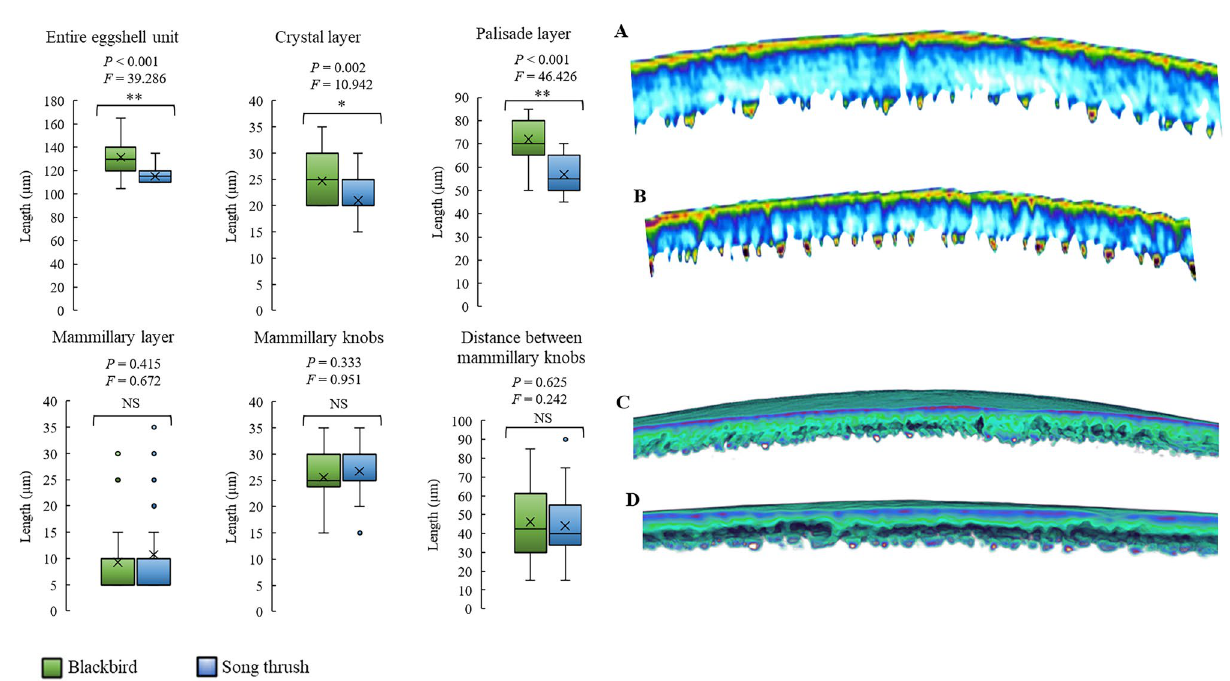
Figure 2. Comparison of the dimensions of individual layers present in the eggshell of blackbird ( Turdus merula ) and song thrush ( Turdus philomelos ). Box plots show the means (cross), standard deviation (box height), and the low and high range (vertical bars). 2D ( A and B ) and 3D ( C and D ) scans of the eggshell of blackbird and song thrush. Significant differences determined by ANOVA: ** P < 0.01; * P < 0.05; NS (no significant differences, P >